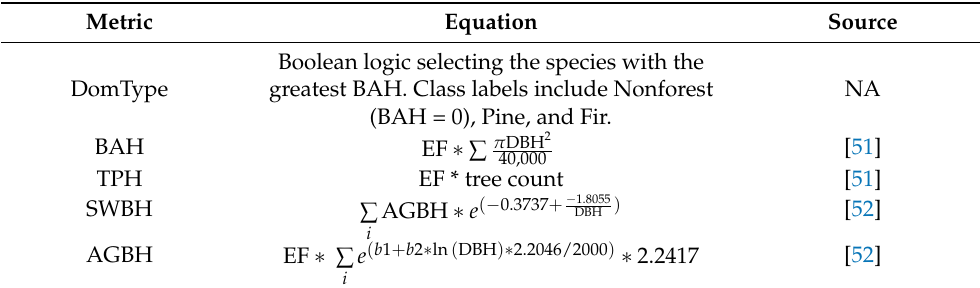
Table 2. List of forest response metrics and calculations used to summarize tree data by species (i) collected at each plot.